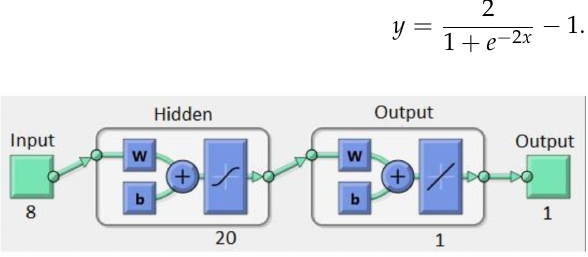
Figure 4. Structure of the ANN used for fitting the circuit